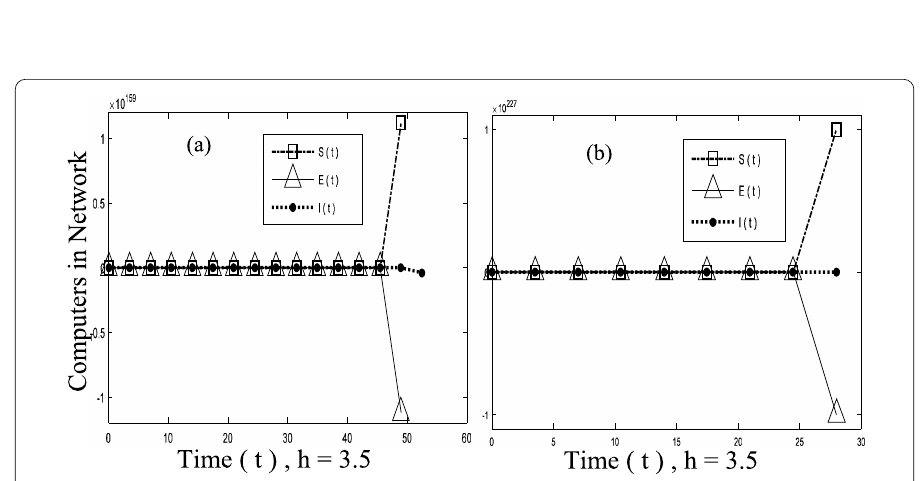
Figure 3 Divergence behaviors of ( a ) Euler method, ( b ) RK-4 method for VFE with h = 3.5